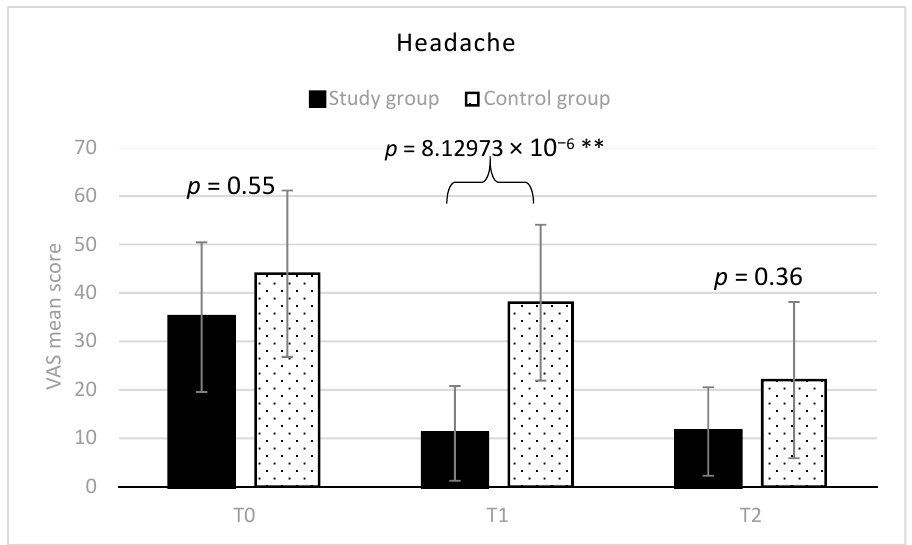
Figure 7. Headache at palpation (mean VAS scores and SD) in the two groups. ** indicates between groups statistically significant differences ( p < 0.01).